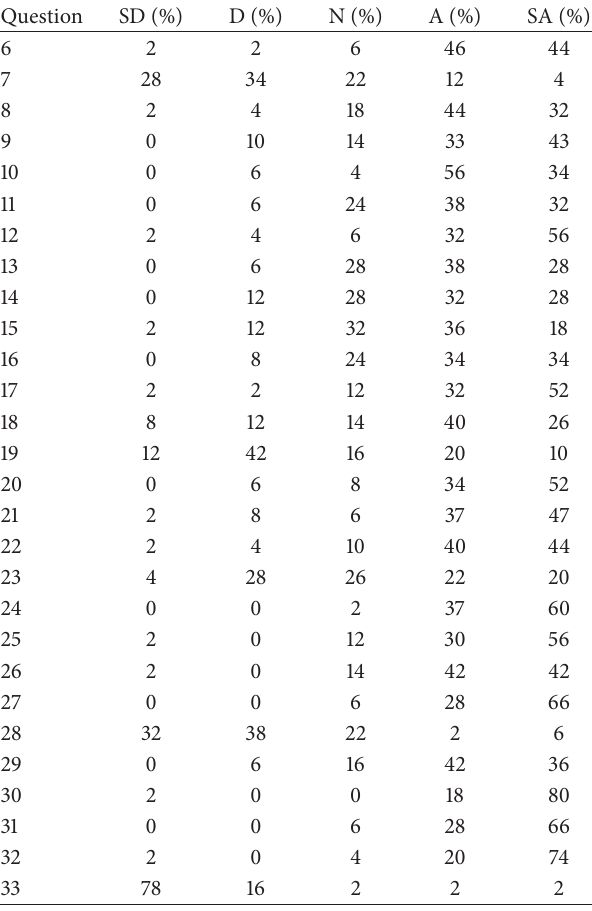
Figure 24: Summary of responses to student opinion survey (Section-A). Table 8: Student evaluation